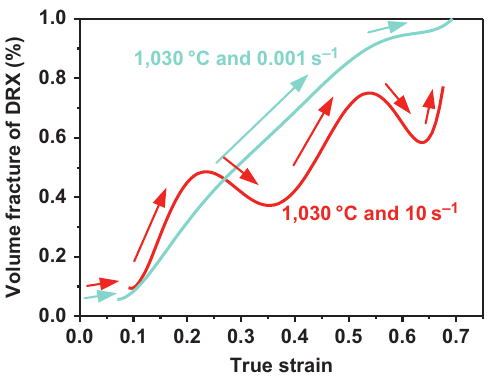
Figure 9: Volume fraction of DRX under the conditions of (a) 1,030°C and 0.001 s − 1 and (b) 1,030°C and 10 s − 1 . (The blue curve and red curve illustrate the CDRX and DDRX types, respectively.)